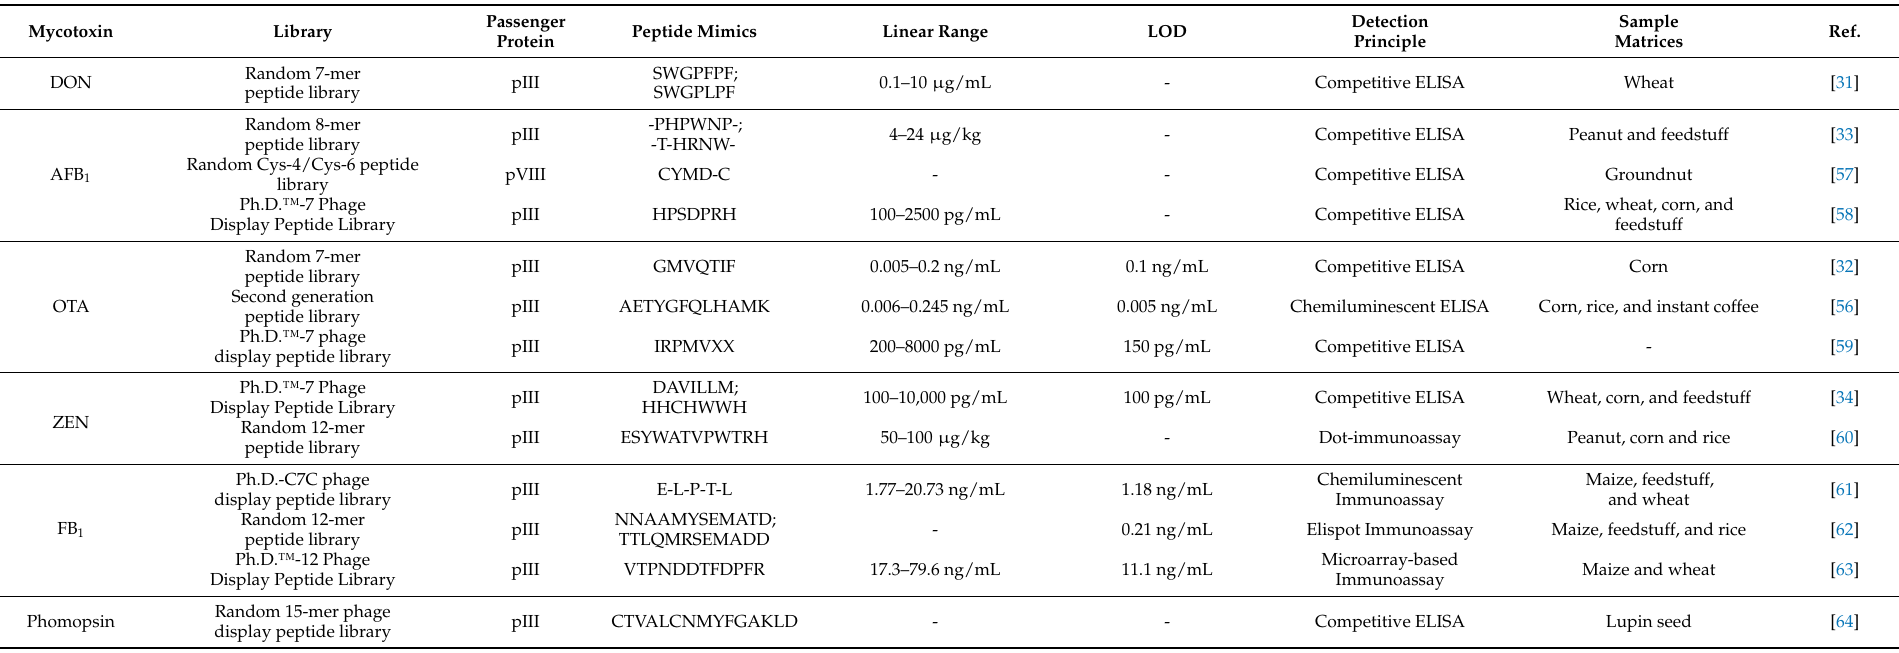
Table 1. Mycotoxins-binding mimotopes screened from phage display